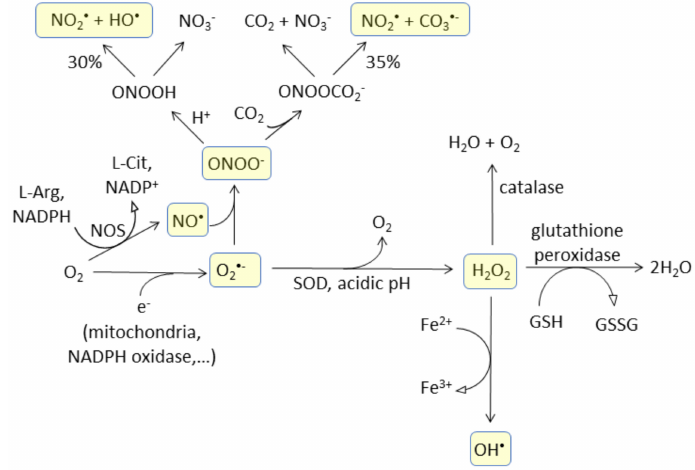
Figure 1. Principal reactive oxygen and nitrogen species (RONS) and a few elimination pathways. (NOS: nitric oxide synthase, L-Arg: L-arginine, L-Cit: L-citrulline, GSH: glutathione, GSSG: glutathione